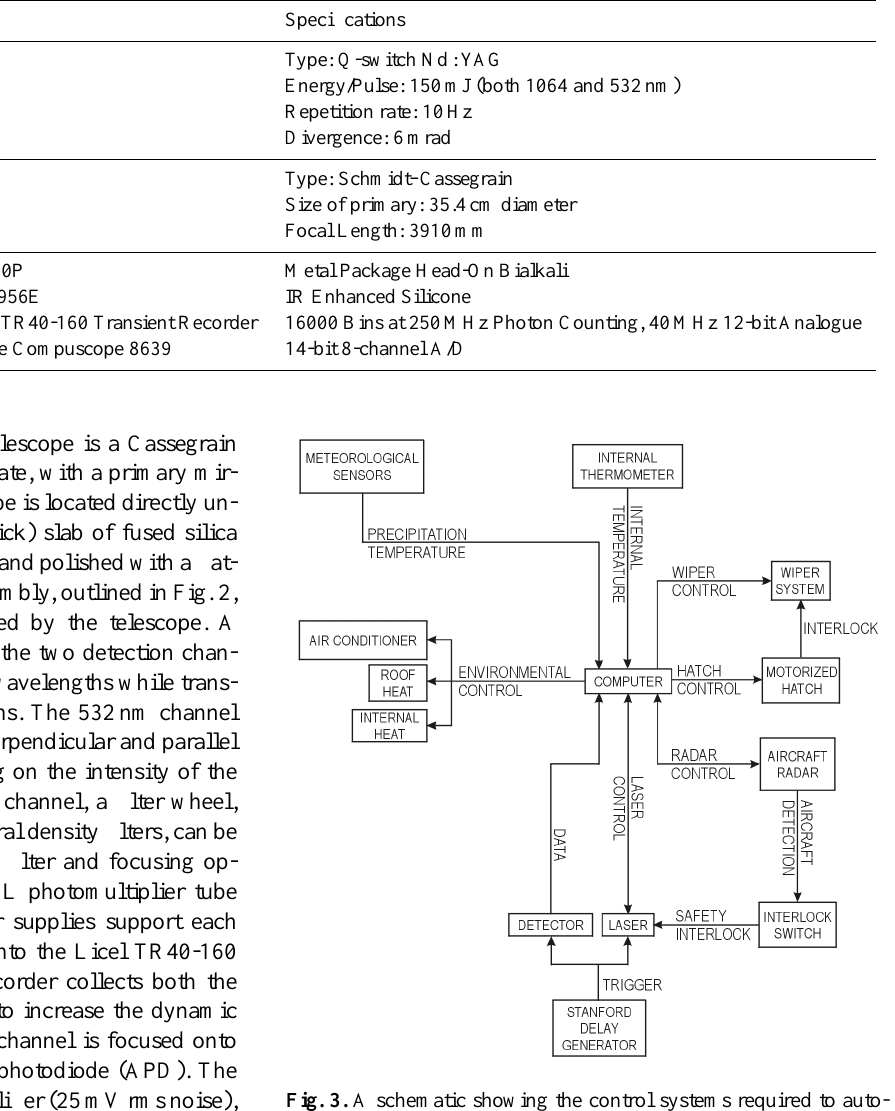
Fig. 3. A schematic showing the control systems required to auto- mate the operation of the lidar for a variety of weather conditions and in the presence of airborne